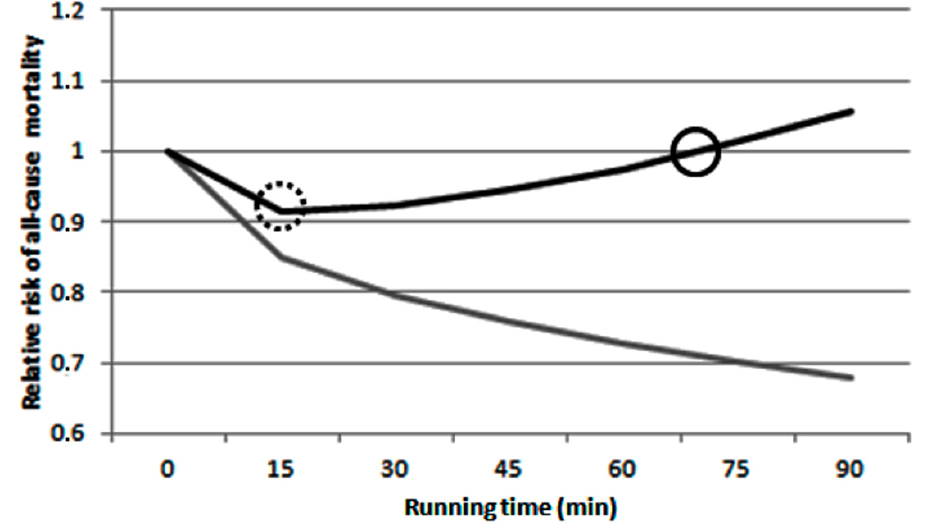
Figure 4. Relative risk of all-cause mortality according to exercise duration in the dirtiest ( black line ) and cleanest ( gray line ) cities. Dotted circle: tipping point; solid circle: break-even point.